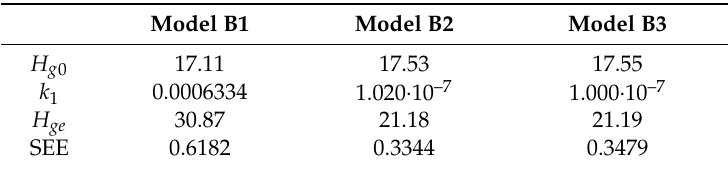
Figure 5. Torrefied barley straw Higher Heating Value of combustion vs. time ( a ), severity factor ( b ), and logarithm of the severity factor ( c ). Table 4. The parameters and standard error of estimate (SEE) of the three models for the Higher Heating Value (MJ/kg) of the combustion of the torrefied barley straw.